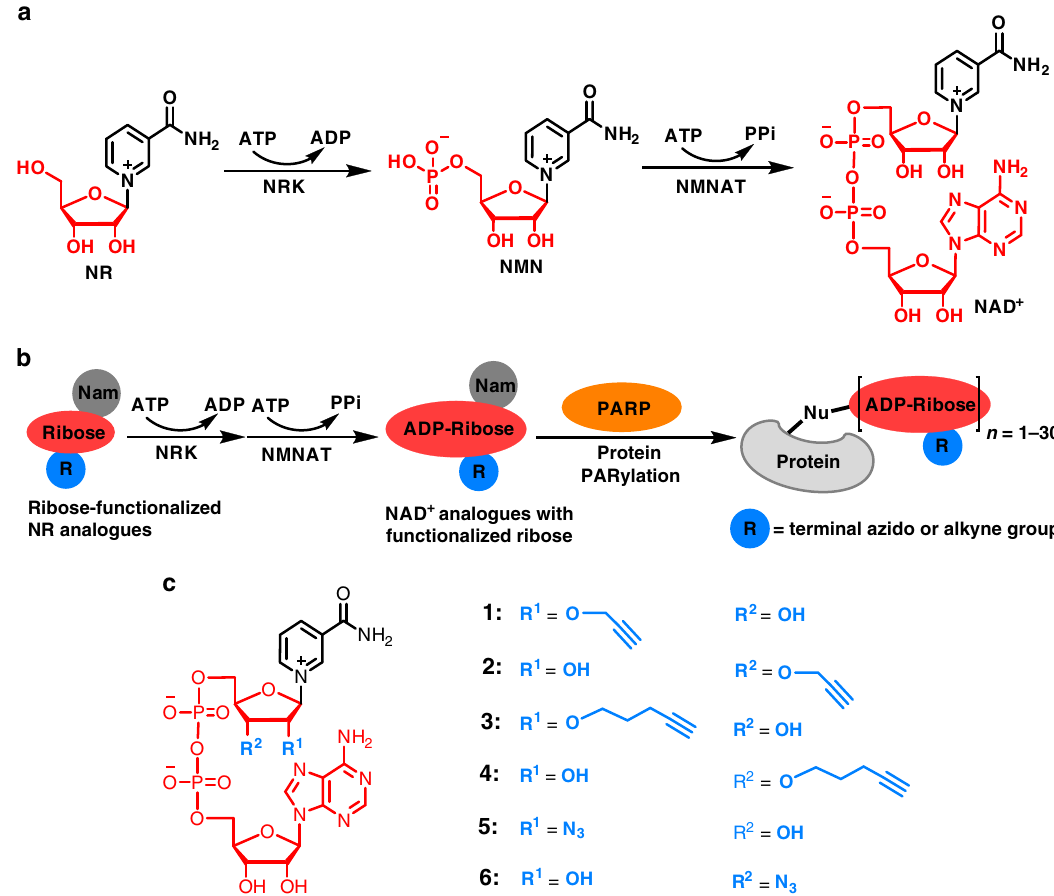
Fig. 1 Biosynthesis of NAD + and ribose-functionalized NAD + analogues. a NRK- and NMNAT-catalyzed formation of NAD + . b Enzymatic synthesis of NAD + analogues with functionalized riboses for protein PARylation. c Chemical structures of NAD + analogue 1 – 6 . PPi: pyrophosphate; Nam: nicotinamide; Nu: nucleophile 2 NATURE COMMUNICATIONS| (2019) 10:4196